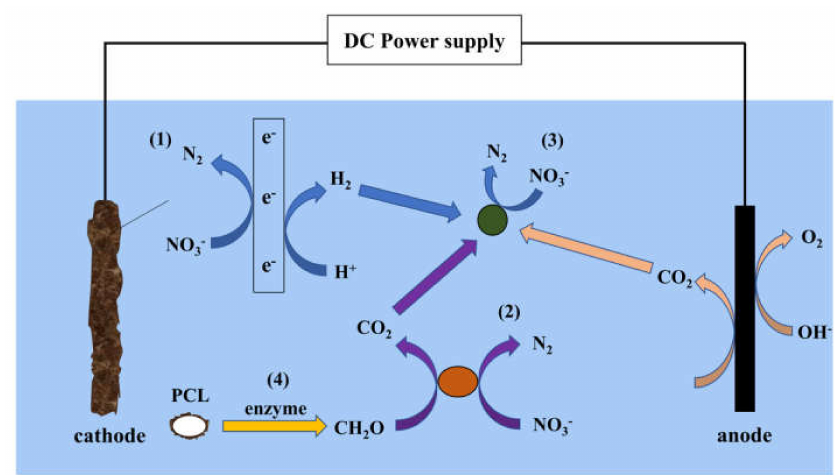
Figure 11. Denitrification mechanism in the SHD − EHD: (1) Electrochemical denitrification reduction; (2) Heterotrophic denitrification; (3) Hydrogen autotrophic denitrification; (4) Hydrolysis of